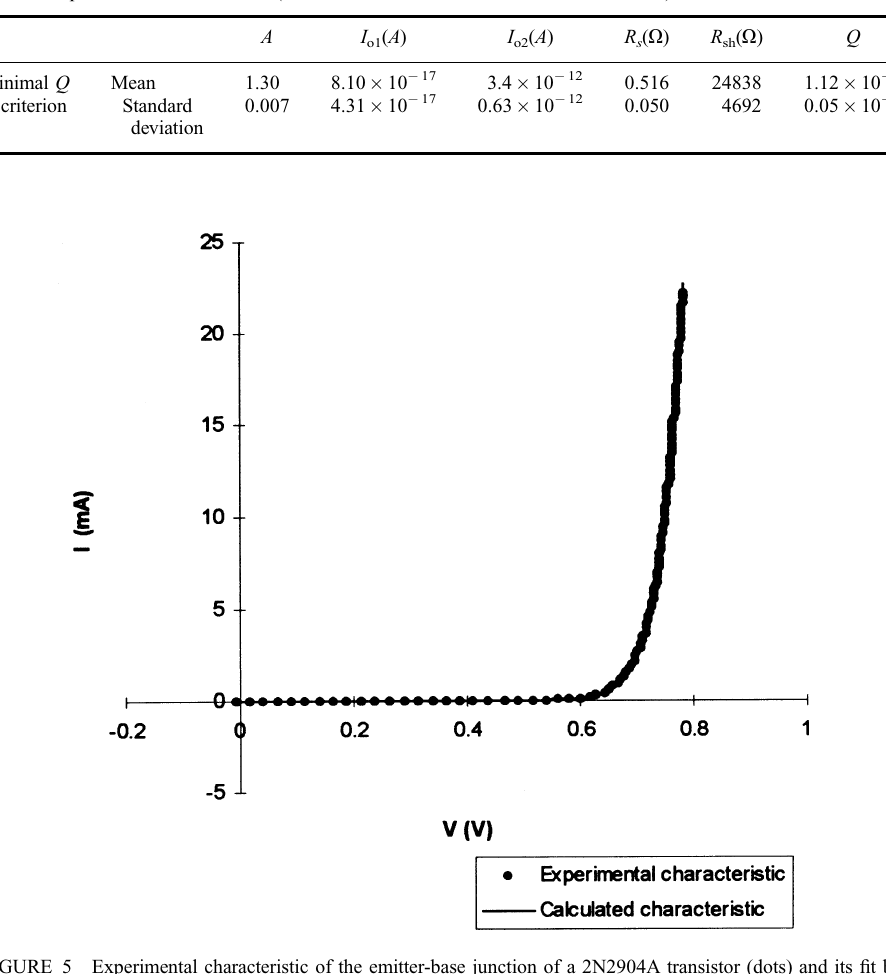
TABLE II Mean and Standard Deviation of the Results Obtained by Successively using 10 Times the Q Criterion with an Experimental Characteristic (Base-Emitter Junction of a 2N2904A Transistor).